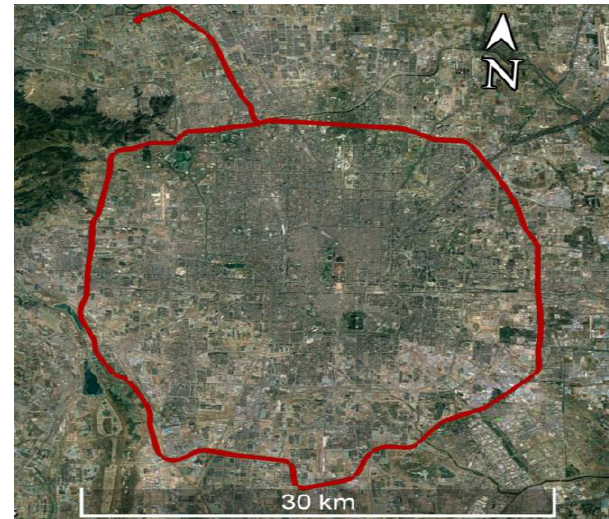
Figure 12. The trajectory of vehicle dynamic test.